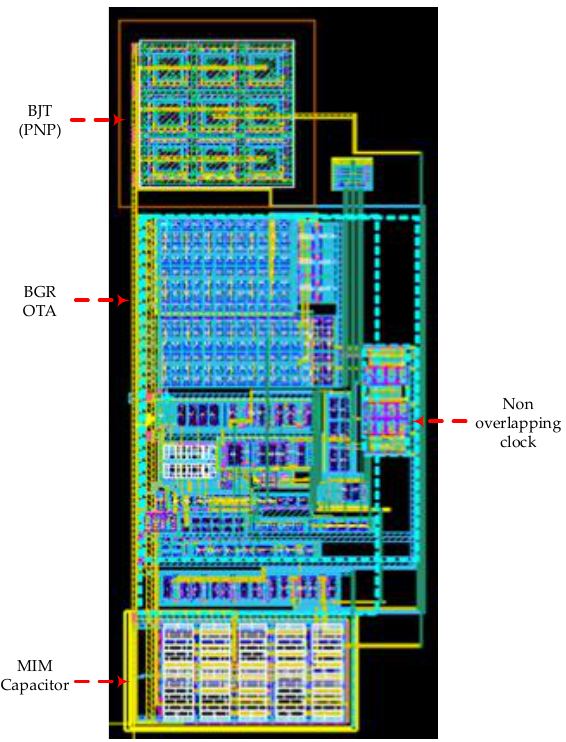
Figure 14. Chopper-embedded BGR and sub-block layout (285.25 μm × 125.38 μm) .